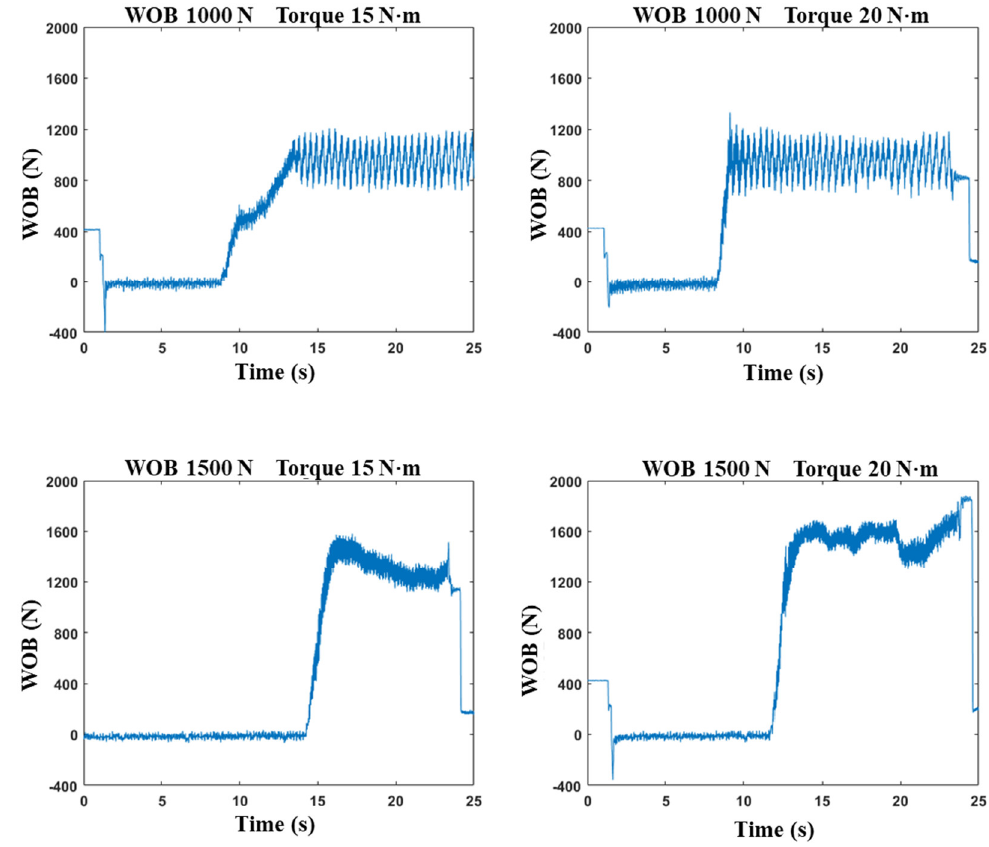
Figure 13. Test results for constant-power drilling mode: the curves of WOB at different setpoints.